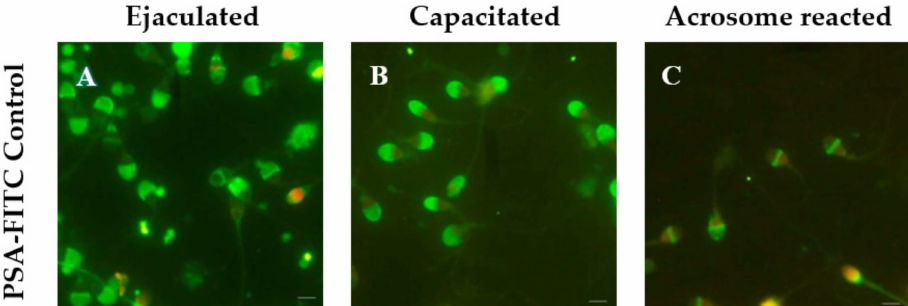
Figure 3. Immunofluorescence reaction for PSA-FITC in ejaculated ( A ), capacitated ( B ) and acrosome-reacted ( C ) spermato- zoa. Preservation of the integrity of the acrosome is observed in a large part of the ejaculated and capacitated spermatozoa, while in acrosome-reacted spermatozoa only the equatorial segment is marked. Scale bar = 5 µ